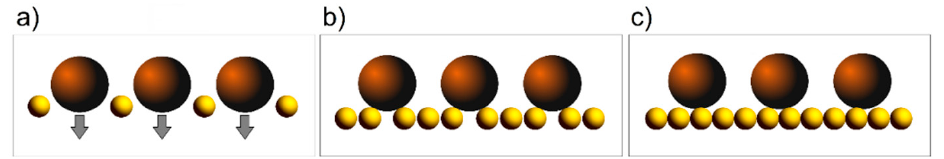
Figure 10. Scheme of transport of solid particles through the emulsion structure at different emulsion concentrations: ( a ) low emulsion concentration, ( b ) medium emulsion concentration, and ( c ) high emulsion concentration.